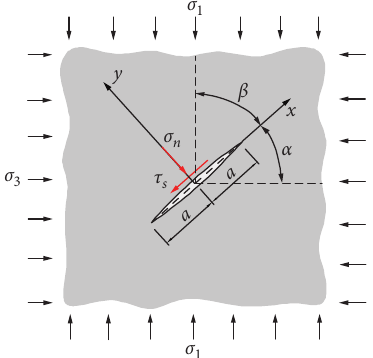
Figure 2: Stress status of an inclined